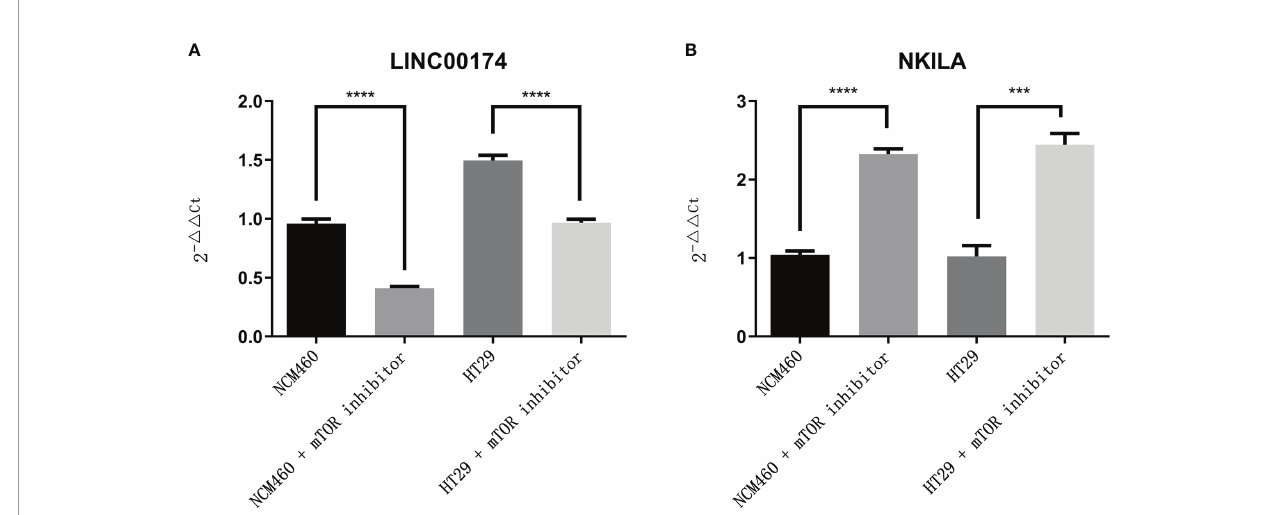
FIGURE 12 | The expression of LINC00174 and NKILA after autophagy activation. (A) LINC00174 , (B) NIKLA . ****p < 0.0001; ***0.0001 < p <